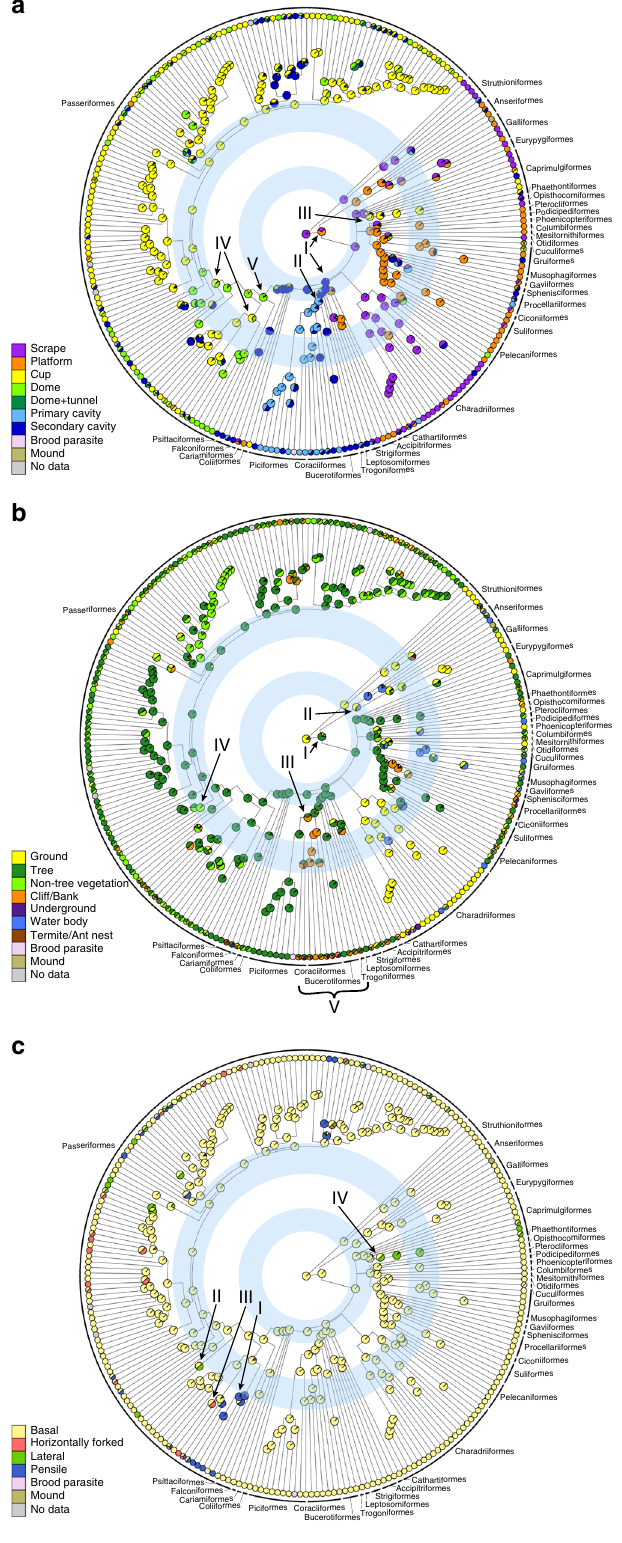
Fig. 2 Phylogenetic distribution of nest character states. Nest character state distributions and ancestral state reconstructions of a nest structure, b nest site, and c nest attachment across an avian family phylogenetic tree. The fi lled colors of circles at tips and nodes of the tree represent nest character states for modern families and their ancestors, respectively. A circle fi lled with multiple colors indicates a family or an ancestral taxon with more than one character state. The families that are brood-parasitic, build mound nests, or have no nest data were excluded from analyses as their nests cannot be characterized, although they are shown in the fi gures for the purpose of comprehension. The blue rings indicate two major adaptive radiations in modern bird evolution. The Roman numerals indicate events discussed in the Results. The avian order names are labeled on the tree (see Supplementary Fig. 8 for family names labeled on the